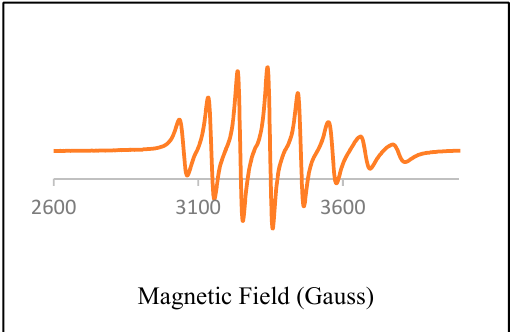
Figure 4. EPR spectrum of [VO(CTZ) 2 ] 2H 2 O in DMF at room temperature.